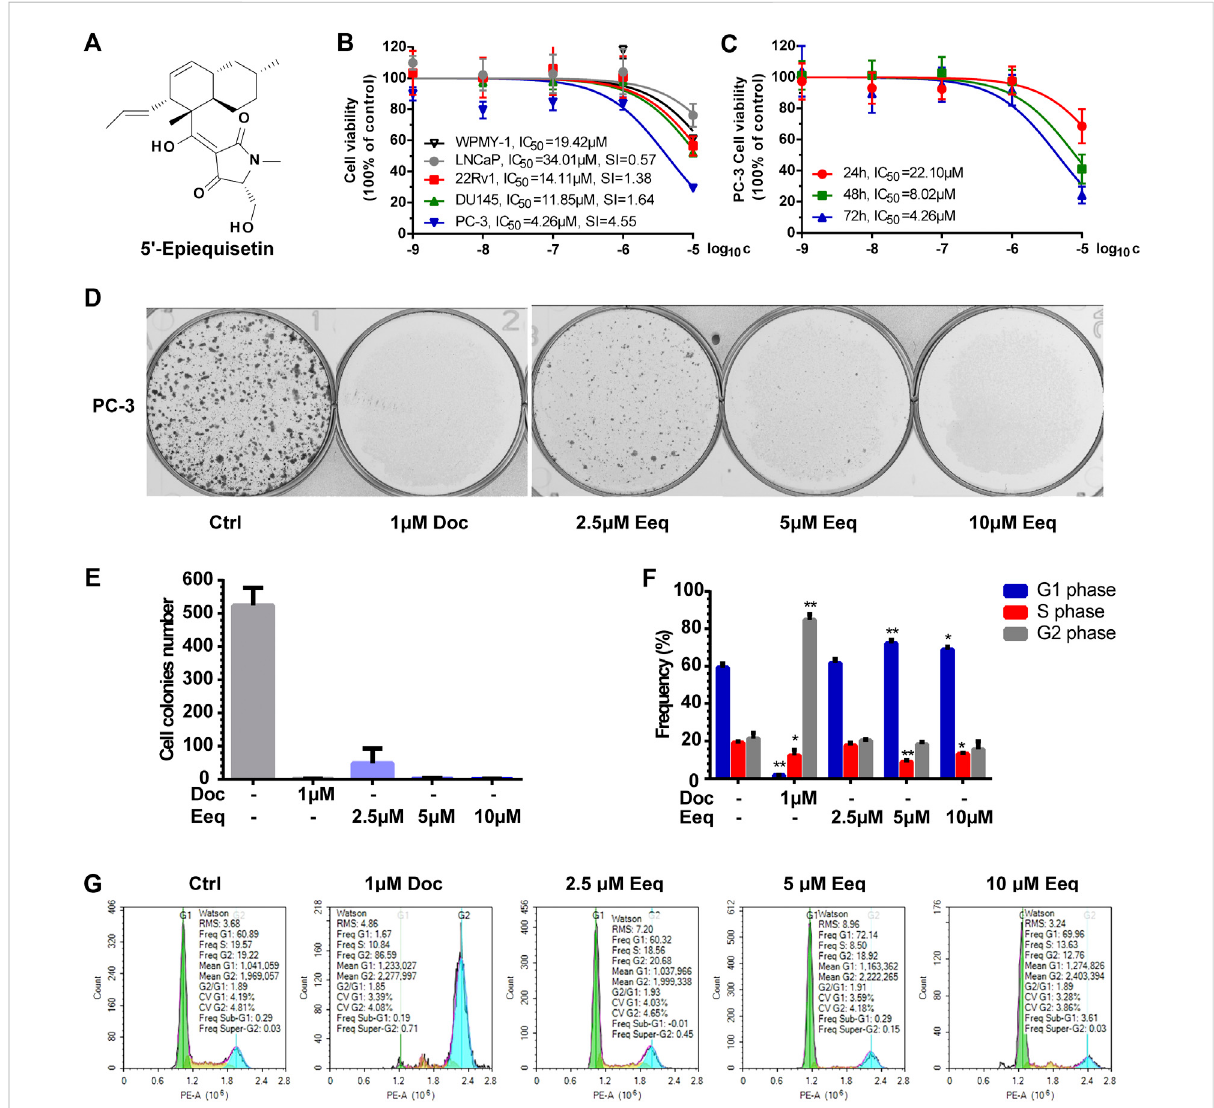
FIGURE 1 5 ′ -Epiequisetin (Eeq) inhibited the proliferation of prostate cancer cells. (A) Chemical structure of Eeq. (B) Eeq inhibited prostate cancer cell viabilitytovaryingdegrees. (C) EeqinhibitedPC-3cellsinatime-dependentmanner. (D,E) EeqreducedPC-3cellcolonyformation. (F,G) Eeqaltered the distribution of PC-3 cell cycle and arrested the cell cycle in the G1 phase. * p < 0.5, ** p < 0.01 vs .